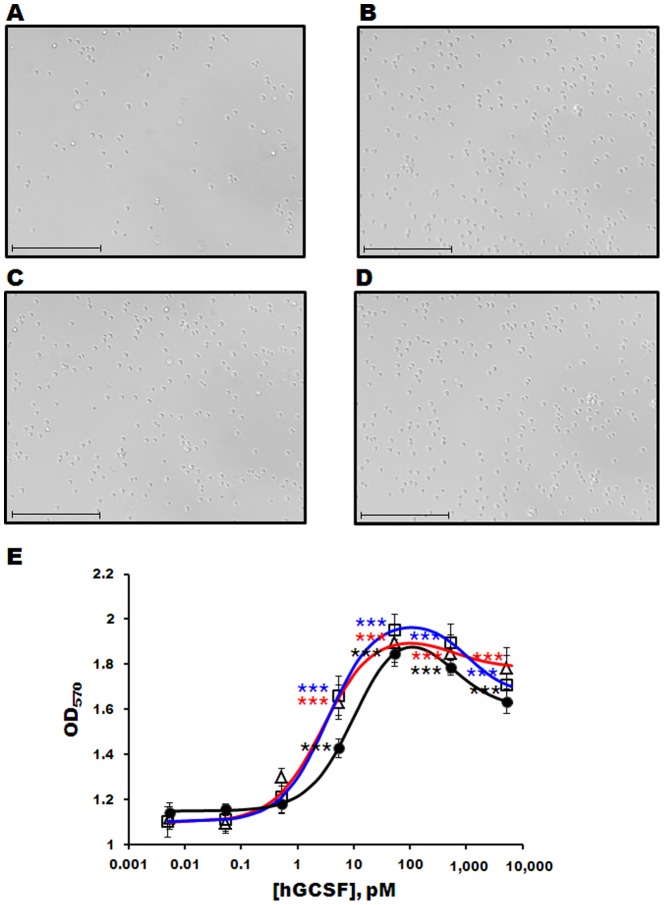
Cell proliferation assay of purified hGCSF using the M-NFS-60 cell line.Light microscopy images of M-NFS-60 cells incubated without (A) or with (B–D) 1 ng/mL hGCSF for 48 h. Commercially available hGCSF (B), hGCSF purified from MBP-hGCSF (C), and GCSF purified from PDIb'a'-hGCSF (D) were used. The scale bar represents 100 µm. E. Dose-response curve of M-NFS-60 cells following exposure to different concentrations of purified hGCSF and commercial hGCSF. The number of cells was measured as the OD570. •, commercially available hGCSF; ▵, hGCSF purified from MBP-hGCSF; hGCSF purified from PDIb'a'-hGCSF. Data are represented as the mean ± SE of n≥3 of 2 independent experiments. Statistical significance compared to no hGCSF treatment group: *, p<0.05; **, p<0.01; ***, p<0.001.